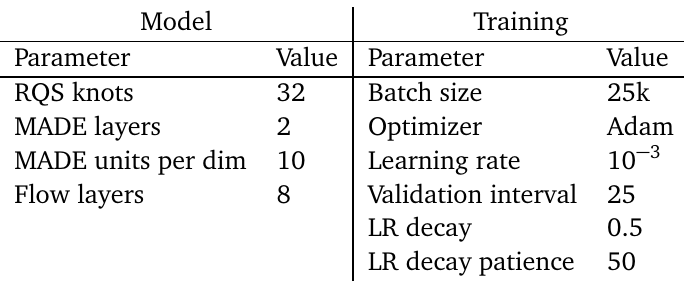
Table 1: Table of hyperparameters and training setup used in the experiments of section